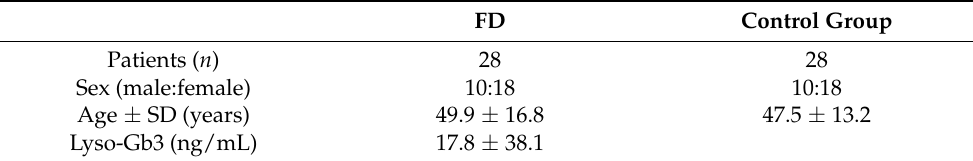
Table 1. Baseline